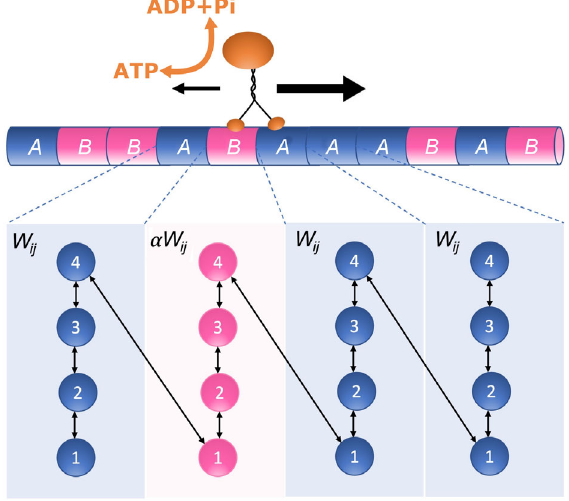
FIG. 14. Sketch of our minimal stochastic model for molecular motor motion in a disordered linear track composed of two types of monomers, A and B . The track is generated as an independent identically distributed sequence of monomers A and B that occur with probabilities p and 1 − p , respectively. Within each perio- dicity cell of type A or B , the motor internal states have the same structure given by a unicyclic network. The transition rates depend on the motor ’ s position on the track according to Eq. (63), where α is a disorder factor. We also assume that the only visible transitions are those related to translocation to the right (step “ forward ” ) þ ¼ 4 → 1 and to the left (step “ back- ward ” ) − ¼ 1 → 4 .